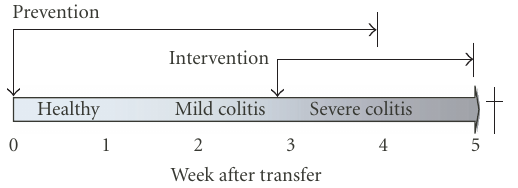
Figure 1: The adoptive transfer colitis model and treatment